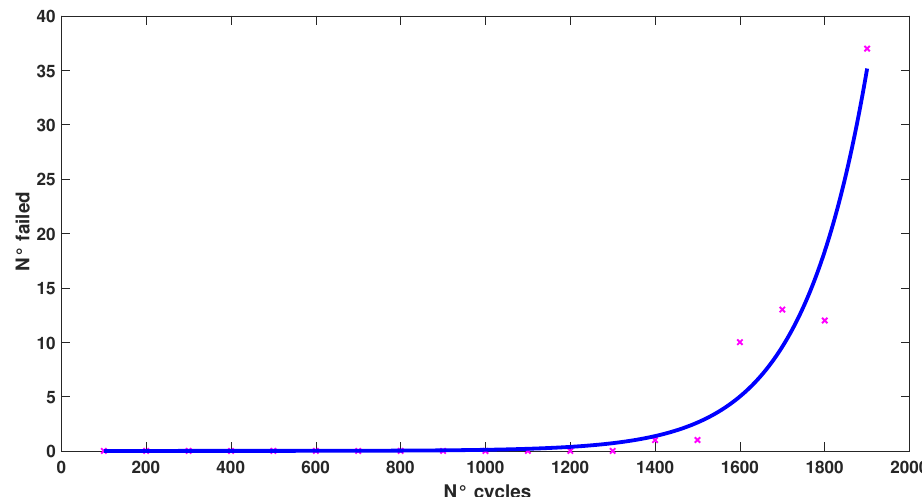
Figure 4. Trend of the failures at each cycle. Markers represent the number of failed determined at each cycle.